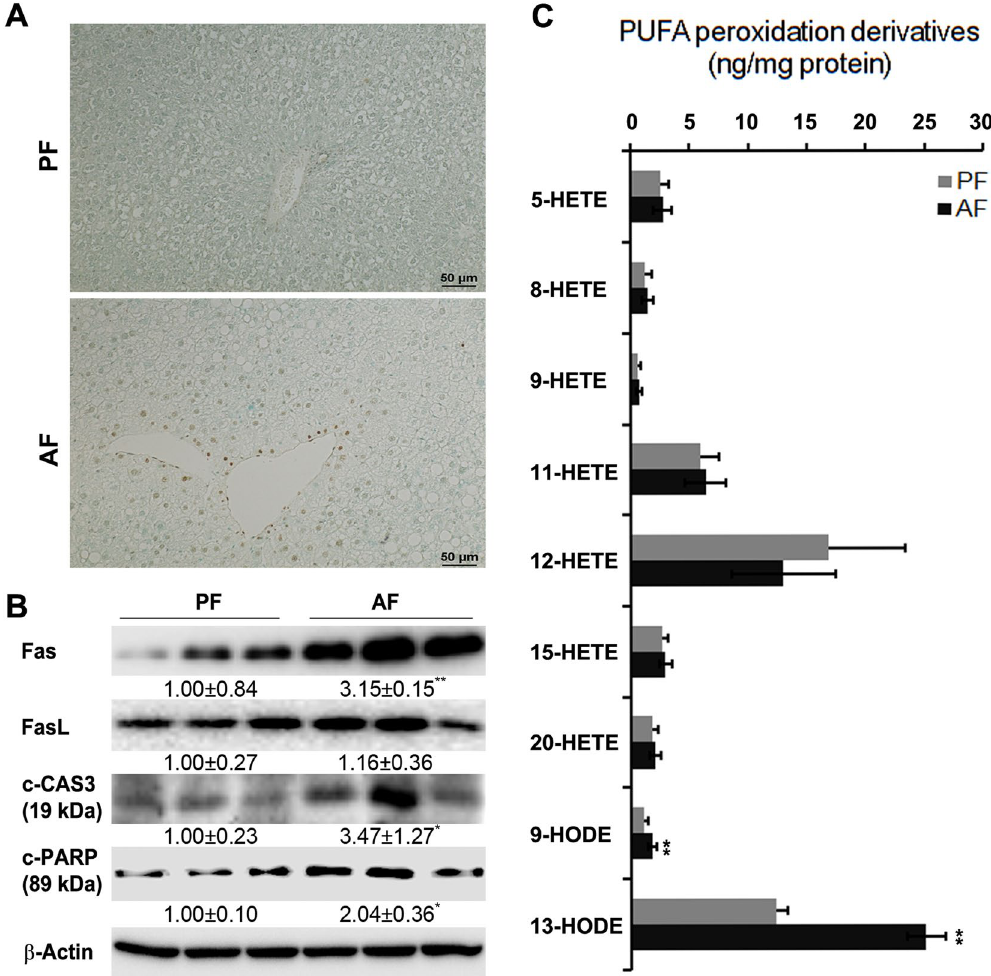
Figure 1. Chronic ethanol feeding induced hepatic apoptosis and increased hepatic HODE levels. WT male mice were fed with control (PF) or alcohol (AF) liquid diet for 8 weeks. ( A ) TUNEL staining of liver sections. ( B ) Immunoblot of proteins involved in apoptosis. Protein levels were quantitated by NIH image J. ( C ) Hepatic HODE and HETE levels measured by LC-MS. All values are denoted as means ± SD (n = 3 in B, n = 6 in C). * P < 0.05, ** P < 0.01. HETE: hydroxyeicosatetraenoic acids, HODE: hydroxyoctadecadienoic acid, PUFA: polyunsaturated fatty